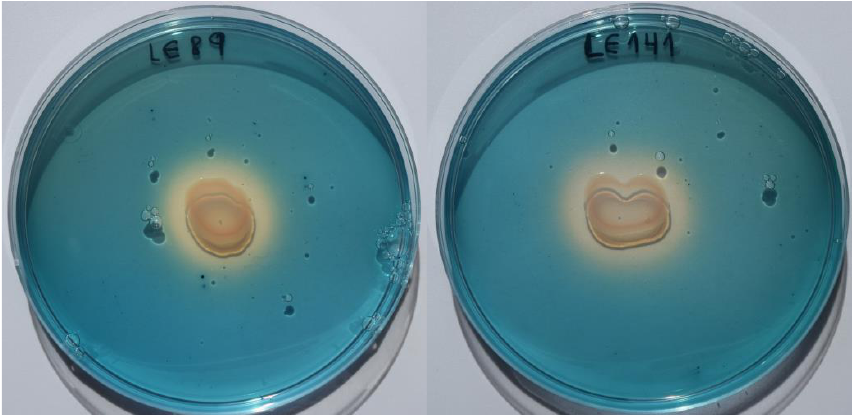
Figure 3. Production of siderophores by Pseudomonas fluorescens LE89 ( left ) and LE141 ( right ) in the CAS-HDTMA medium.